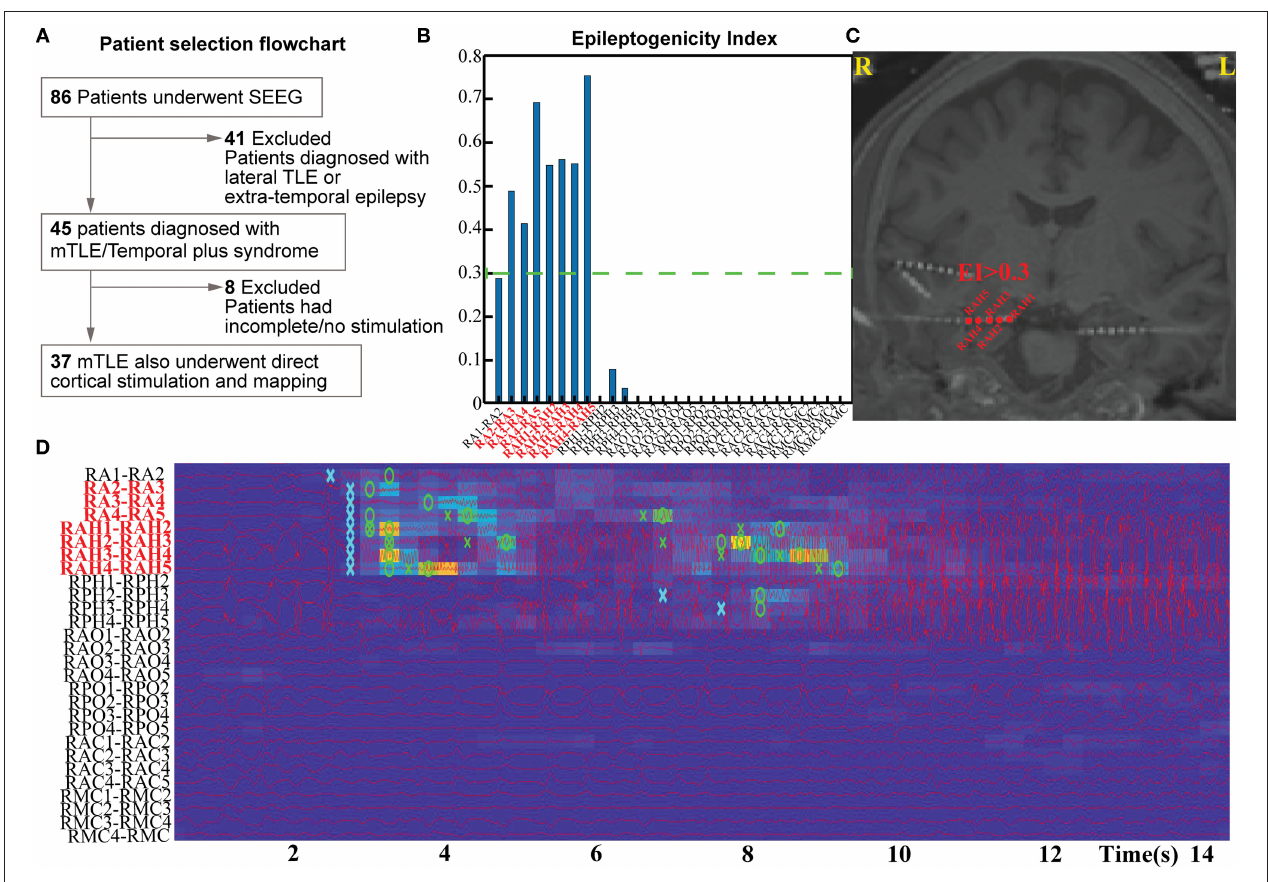
FIGURE 1 | Patient selection flow chart (A) and estimation pipeline for Epileptogenicity Index (EI) for their seizures (B–D)